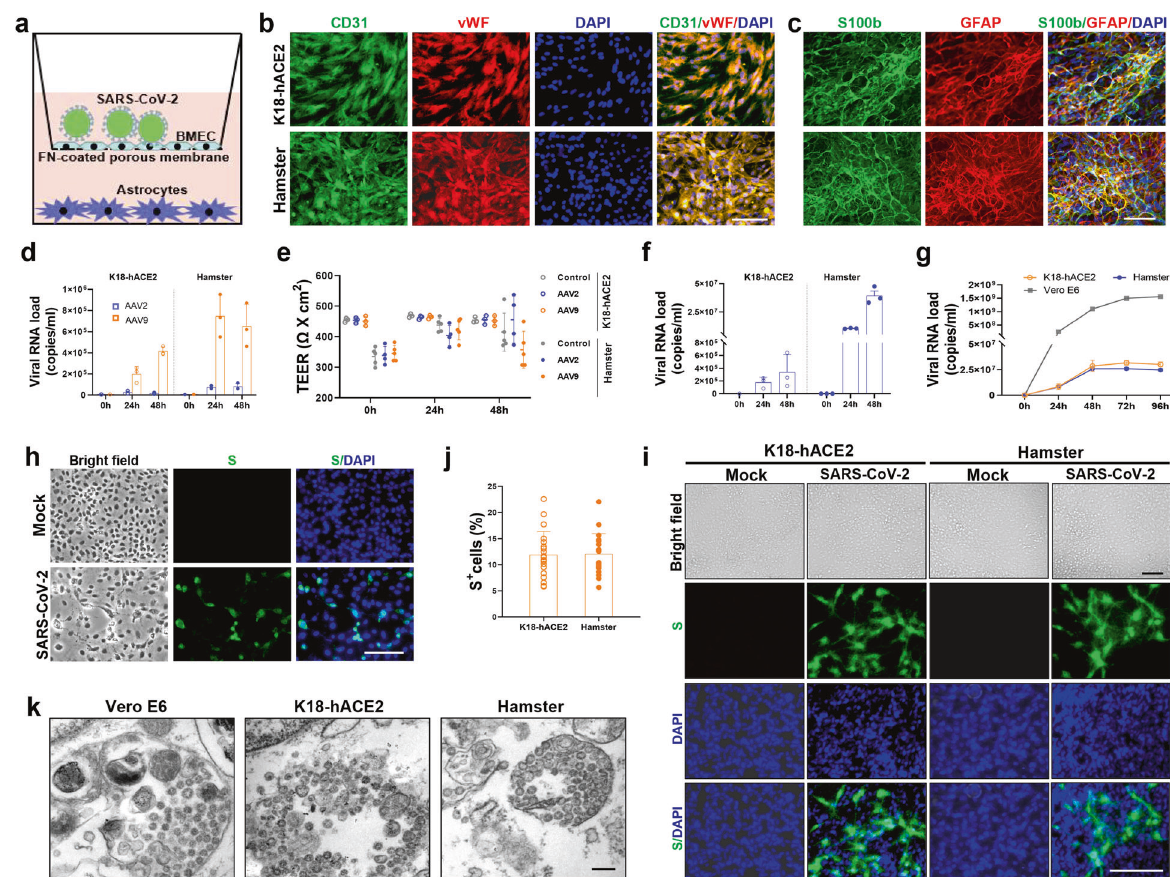
Fig. 4 SARS-CoV-2 infected and replicated in the BMECs, and crossed the BBB in vitro . a Schematic diagram of in vitro BBB models. b – e Evaluation of in vitro BBB models, including b identi fi cation of primary hamster BMECs by immuno fl uorescent staining for CD31 and vWF, c immuno fl uorescent staining for GFAP and S100b, markers of astrocytes, the ability of AAV2 and AAV9 to cross the BBB models assessed by d viral RNA load in the medium from the bottom chamber and e transendothelial electrical resistance (TEER) in both primary BMECs from K18- hACE2 mice and hamster transwell cultures. f SARS-CoV-2 viral load in the medium from the bottom chamber quanti fi ed by qRT-PCR in BBB models using primary cell cultures from K18-hACE2 mice and hamsters. g Viral load in the medium of BMECs and Vero E6 cells quanti fi ed by qRT-PCR. h Representative images of SARS-CoV-2-S (S) in Vero E6 cells at 48 hpi detected by FISH. i Representative images of SARS-CoV-2-S (S) in BMECs at 48 hpi detected by FISH. j Percentage of SARS-CoV-2-S positive (S + ) BMECs by FISH ( n = 20 fi elds/group at ×200). k Representative ultrastructural images showing virus particles in the BMECs and Vero E6 cell. N = 3/group. Scale bars: b , d , h , i 100 μ m; k 200